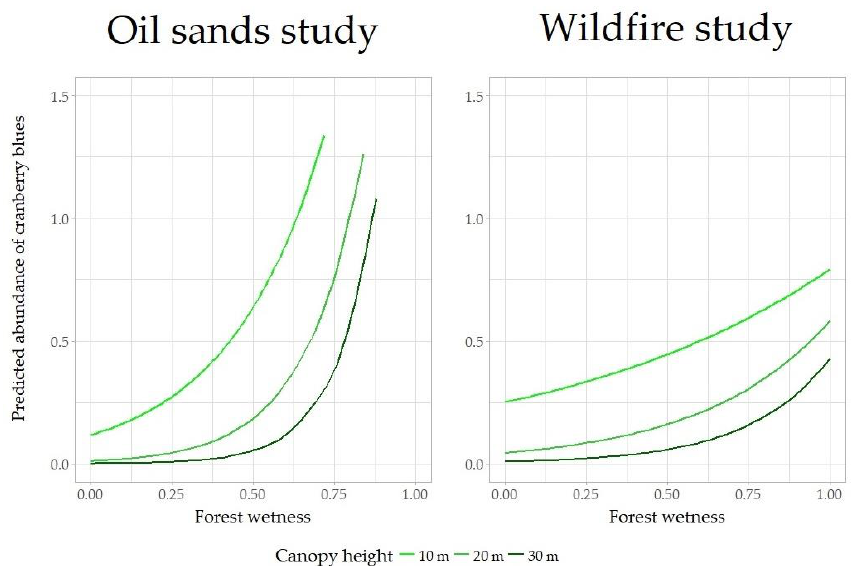
Figure 5. Predicted posterior mean of the abundance of cranberry blues ( λ , y axis, with N ~ Poisson ( λ )) as a function of forest wetness (x axis) and canopy height (line color). Model predictions refer to point-count samples conducted in seismic lines.